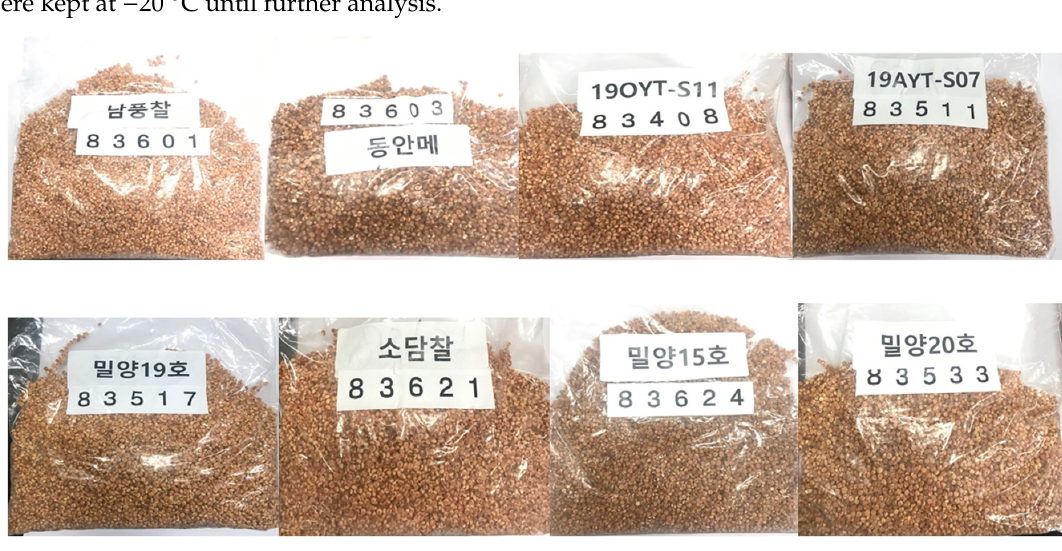
Figure 4. Pictures of decorticated sorghum grains.